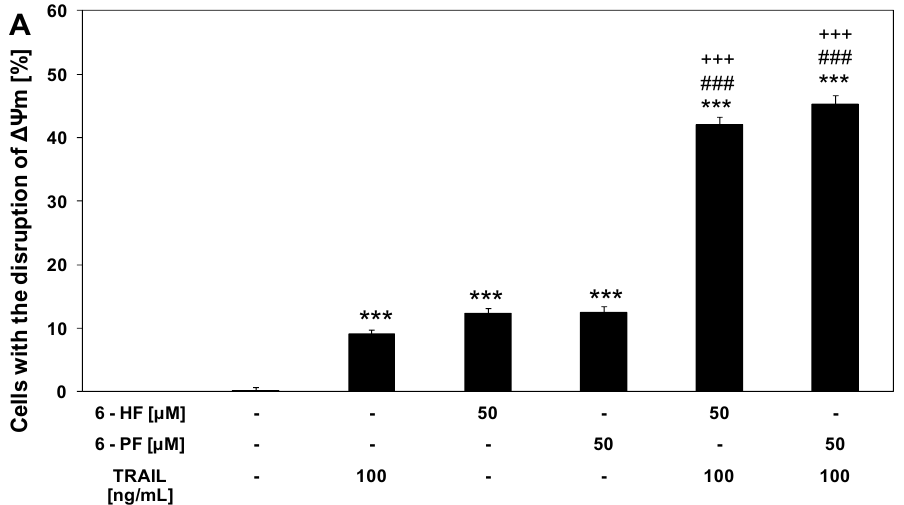
Figure 6. Effects of TRAIL in combination with synthetic flavanones on the mitochondrial membrane potential ( ΔΨ m) in HeLa cancer cells. Cells were incubated for 48 h with TRAIL at the concentration of 100 ng/mL and 6-HF or 6-PF at the concentration of 50 μ M. The values represent the mean ± SD of three independent experiments performed in quadruplicate ( *** p < 0.001 compared with control, ### p < 0.001 compared with 6-HF or 6-PF and +++ p < 0.001 compared with TRAIL). ( A ) TRAIL in combination with flavanones induced loss of ΔΨ m in HeLa cells; ( B ) Disruption of ΔΨ m in cancer cells was assessed by fluorescent microscopic analysis of DePsipher staining: ( a ) control cells; ( b ) cells incubated with 100 ng/mL TRAIL; ( c ) cells incubated with 50 μ M 6-HF; ( d ) cells incubated with 100 ng/mL TRAIL and 50 μ M 6-HF; ( e ) cells incubated with 50 μ M 6-PF; ( f ) cells incubated with 100 ng/mL TRAIL and 50 μ M 6-PF. Red fluorescence is emitted from the red aggregates of DePsipher which are formed within mitochondria in healthy cells. Green fluorescence reveals the monomeric form of the DePsipher molecule, which appears in the cytosol after mitochondrial membrane depolarization (indicated by